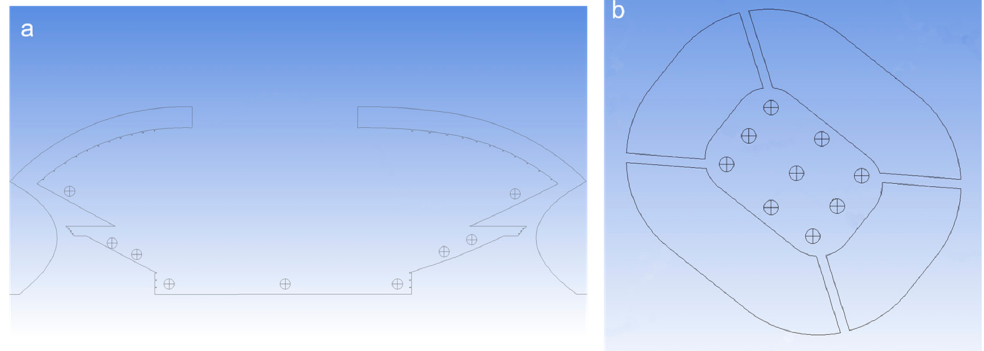
Figure 3. ( a ) Measurement points on the cross-section of the stadium for the grid independence study. ( b ) Measurement points on the pitch for the grid independence study.